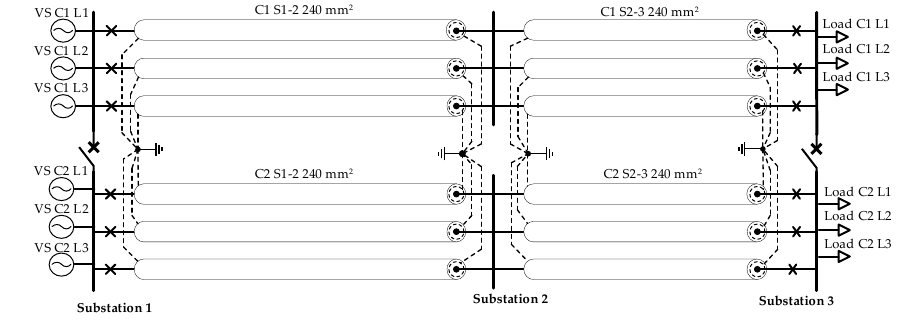
Figure 23. Overall structure of the cable lines system model.